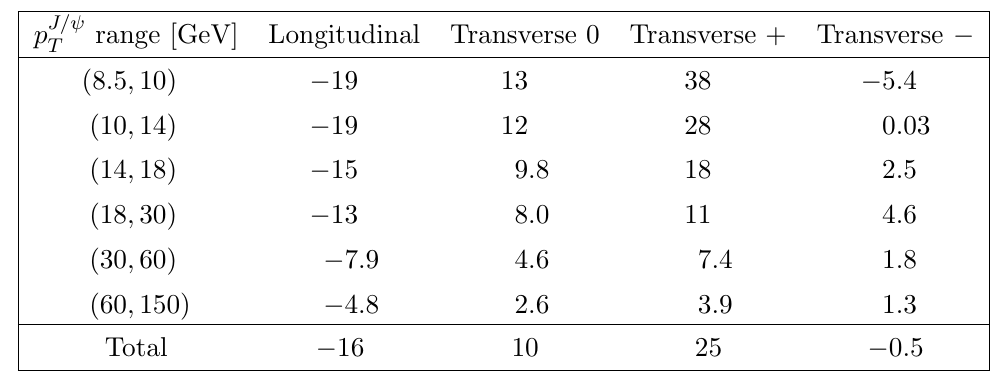
Table 5. Percentage variations on the di(cid:11)erential distribution for four extreme cases of J= spin alignment of maximal polarisation relative to the nominal unpolarised assumption for 1 < j y j < 2 : 1 [2]. J=